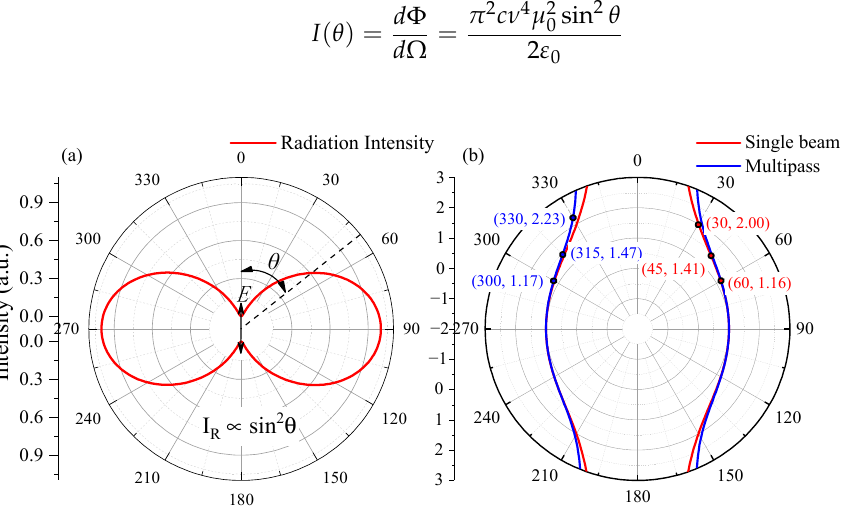
Figure 1. ( a ) Simulation result of angular distributions of the radiant intensity, I R ; ( b ) simulation result of angular distributions of Raman scattering intensity with a single laser beam (red line) and multi-laser beam (blue line).